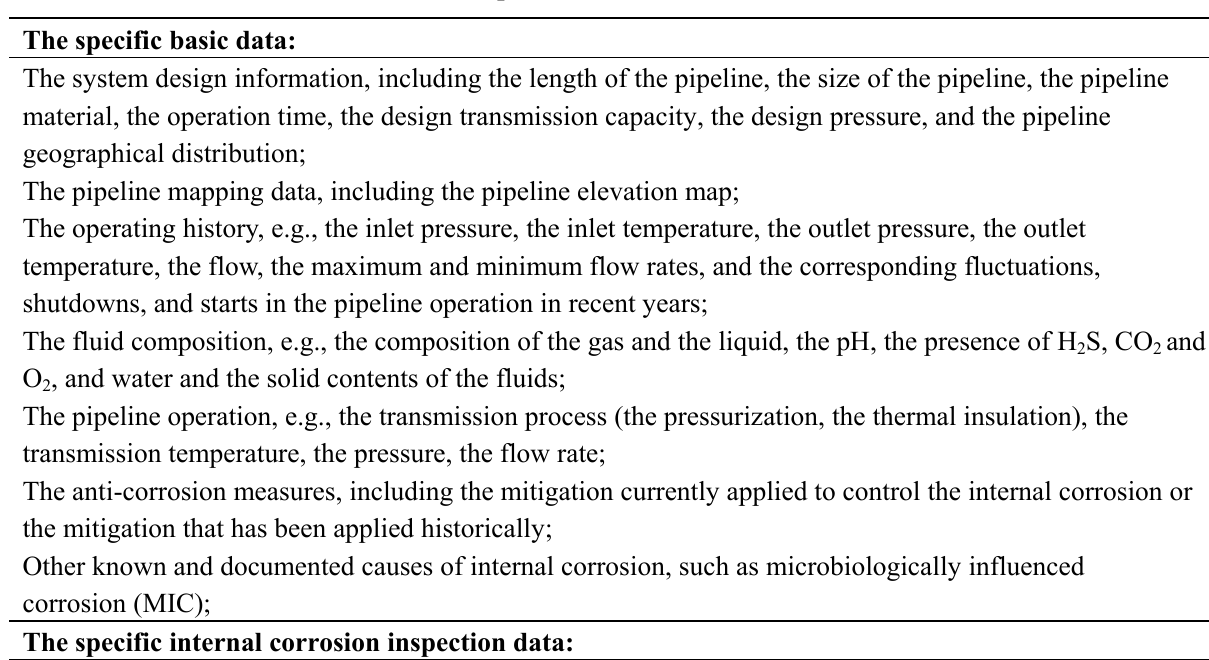
Table 1. The specific data that must be collected.